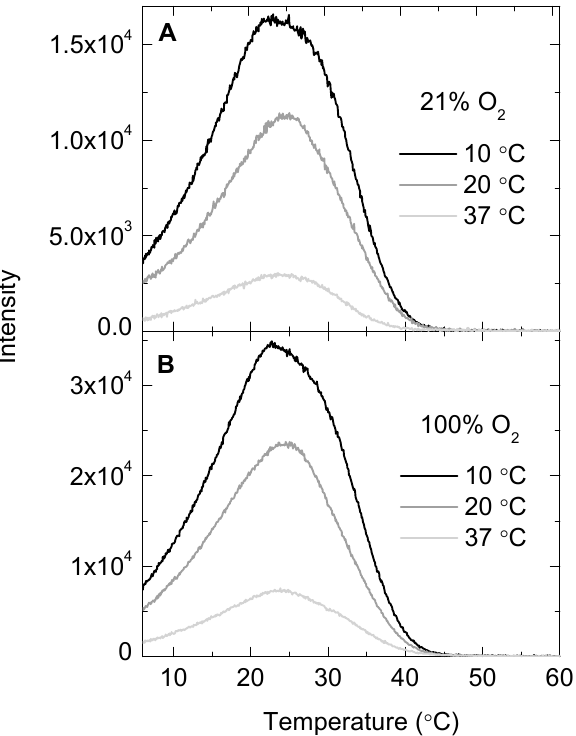
Figure 2. Temperature ramp of the chemiluminescence traces of the Singlet Oxygen Chemiluminescence (SOCL) phenoxy-dioxetane derivative after the photo-oxygenation of SOCL with 1 O 2 in phosphate buffer saline pH 7.4 at three different temperatures. The photo-oxygenation reactions were performed in equilibrium with an atmosphere of 21% O 2 ( A ) or 100% O 2 ( B ). Before monitoring the chemiluminescence traces, the reaction mixtures were set in the oxygen electrode chamber, where 2 μ M methylene blue was present as 1 O 2 photosensitizer and 0.5 mM SOCL as 1 O 2 quencher. The reaction mixtures were illuminated with a red light-emitting diode source with an intensity of 2 mE m − 2 s − 1 for 2 min. Samples were taken from the oxygen electrode chamber after illumination and cooled down in a 1 cm fluorescence cuvette for 2 min to reach a temperature of 6 ° C before the temperature ramp started. The rate of the temperature ramp was 5 ° C min − 1 .